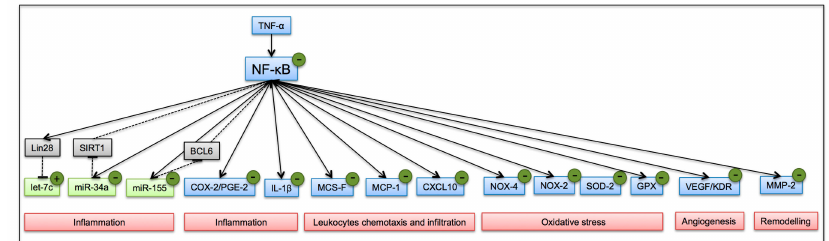
Figure 11. A working model of action for OC and OA in TNF- α -stimulated adipocytes. Continuous line, active; dashed line, inhibit; blue box, gene; green box, miRNA; gray box, intermediate knots; red box, processes; polyphenols e ff ect: ( − ) decrease; ( + ) increase. Supplementary Materials: The following are available online at http: // www.mdpi.com / 2072-6643 / 11 / 12 / 2855 / s1, Figure S1: Oleocanthal (OC)-p50 / p56 complexes analyzed with Molecular dynamics (MD). The five OC-p50 / p65 complexes studied with MD simulations are shown, together with the DNA fragment bound to the heterodimer in the reference X-ray structure. In complex 1 (A), complex 2 (B), complex 3 (C), complex 4 (D) and complex 5 (E), the ligand is shown as spheres and colored green, black, orange, red and blue, respectively, while the bound DNA fragment (F) is colored in dark cyan. In all complexes, the p50 and p65 subunits are shown as pink and purple ribbons respectively, while cys38 and cys120 are shown as yellow spheres, Figure S2: Minimized average structure of OC bound to IKK β catalytic site, derived from the last 20 ns of MD simulation. Hydrogen bonds are represented as black dashed lines. Table S1: Gene ontology (GO) Biological Processes (BP) significantly associated to miR-155-5p and miR-34a-5p, Table S2: Gene ontology (GO) Biological Processes (BP) significantly associated to let-7c-5p, Table S3: Molecular Mechanic-Poisson Boltzmann surface area (MM-PBSA) evaluation. MM-PBSA results for four analyzed oleocanthal (OC)-p50 / p65 complexes. ∆ PBSA is the sum of the electrostatic (ELE), van der Waals (VDW), polar (EPB) and non-polar (ENPOLAR) solvation free energy. Data are expressed as kcal · mol − 1